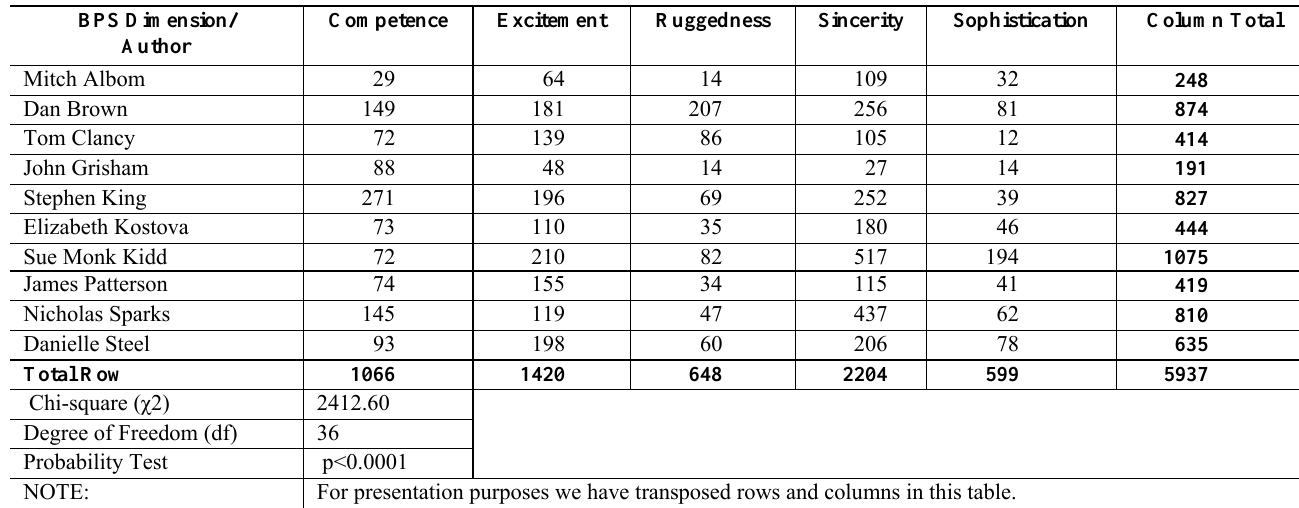
Table 2 Distribution of brand personality dimensions over